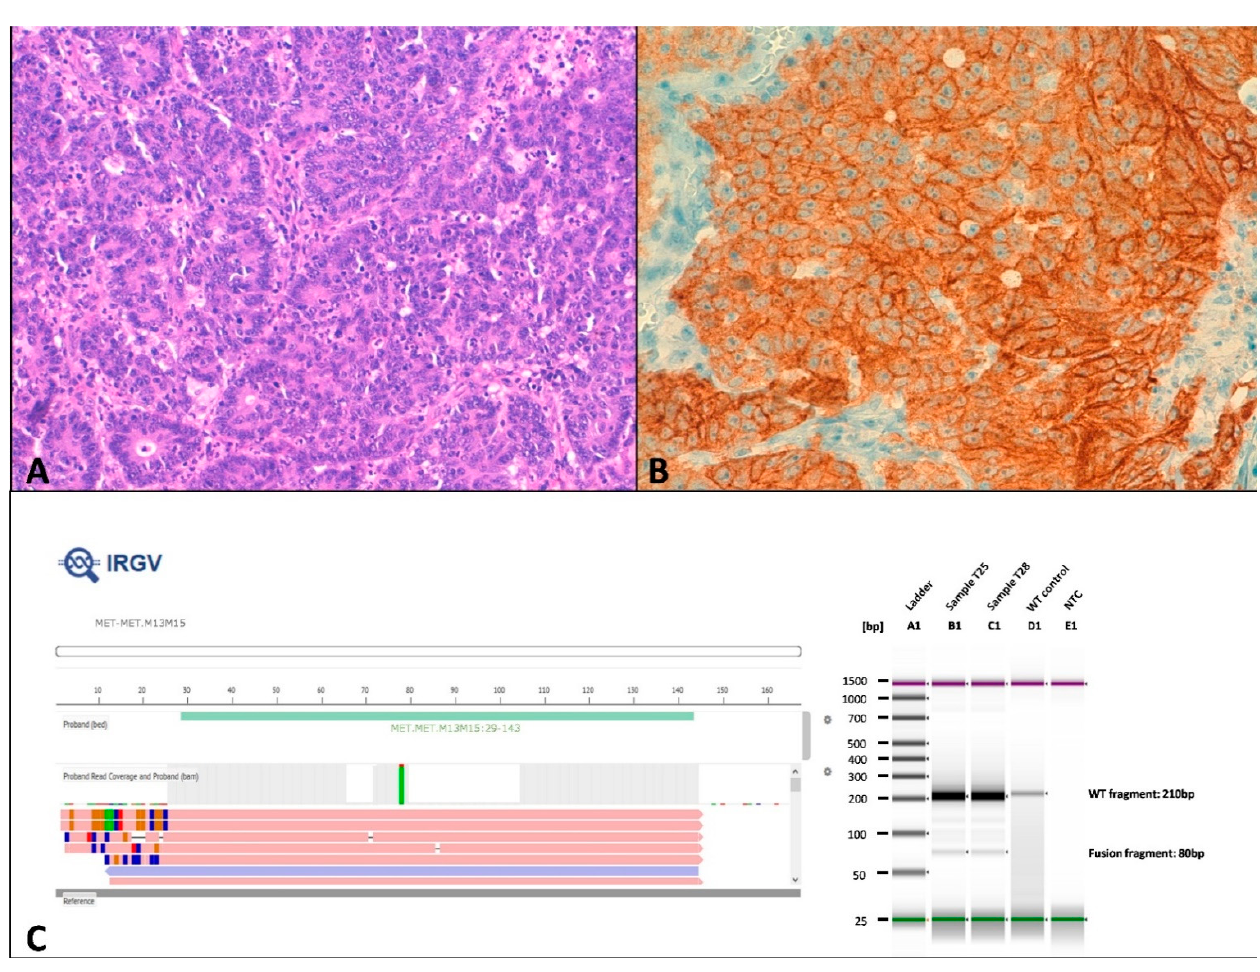
Figure 6. c- MET traslocation in tumor T28. ( A ) Hematoxylin-eosin showing a grade 3 tumor with scarce glandular formation. ( B ) c-MET immunostaining was diffuse and intense. ( C ) On the left, Ion Reporter Genomic Viewer (IRGV) image, corresponding to the MET(13)-MET(15) fusion. On the right, fusion validation by RT-PCR.